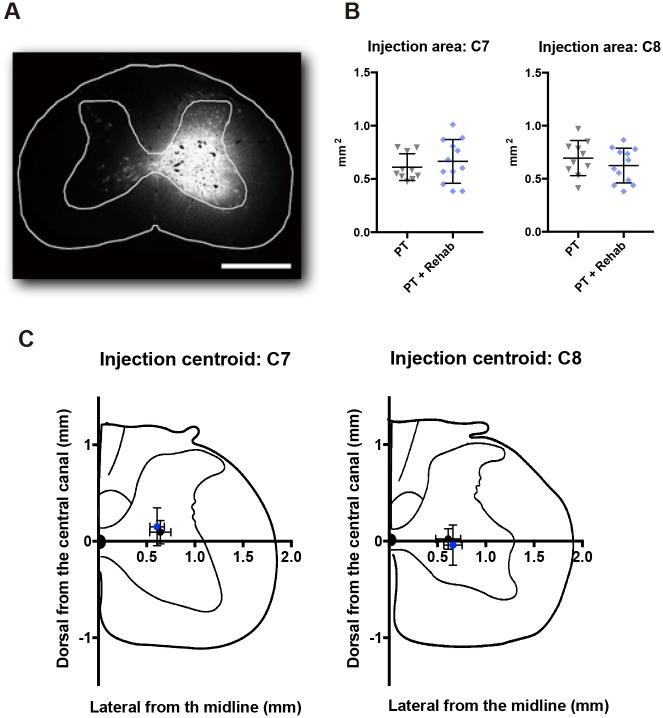
Tracer injection validation.(A) Representative photo of the Fast blue injection in the spinal cord. Scale bar = 1 mm. (B) Injection area of Fast blue at the C7 and C8 spinal levels was not significantly different between groups. (C) There were no significant differences between groups in the location of the injection centroid at the C7 and C8 spinal levels.